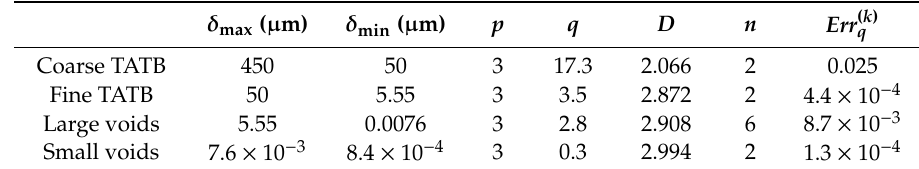
Table 5. The model parameters of the NU model of the LX-17.